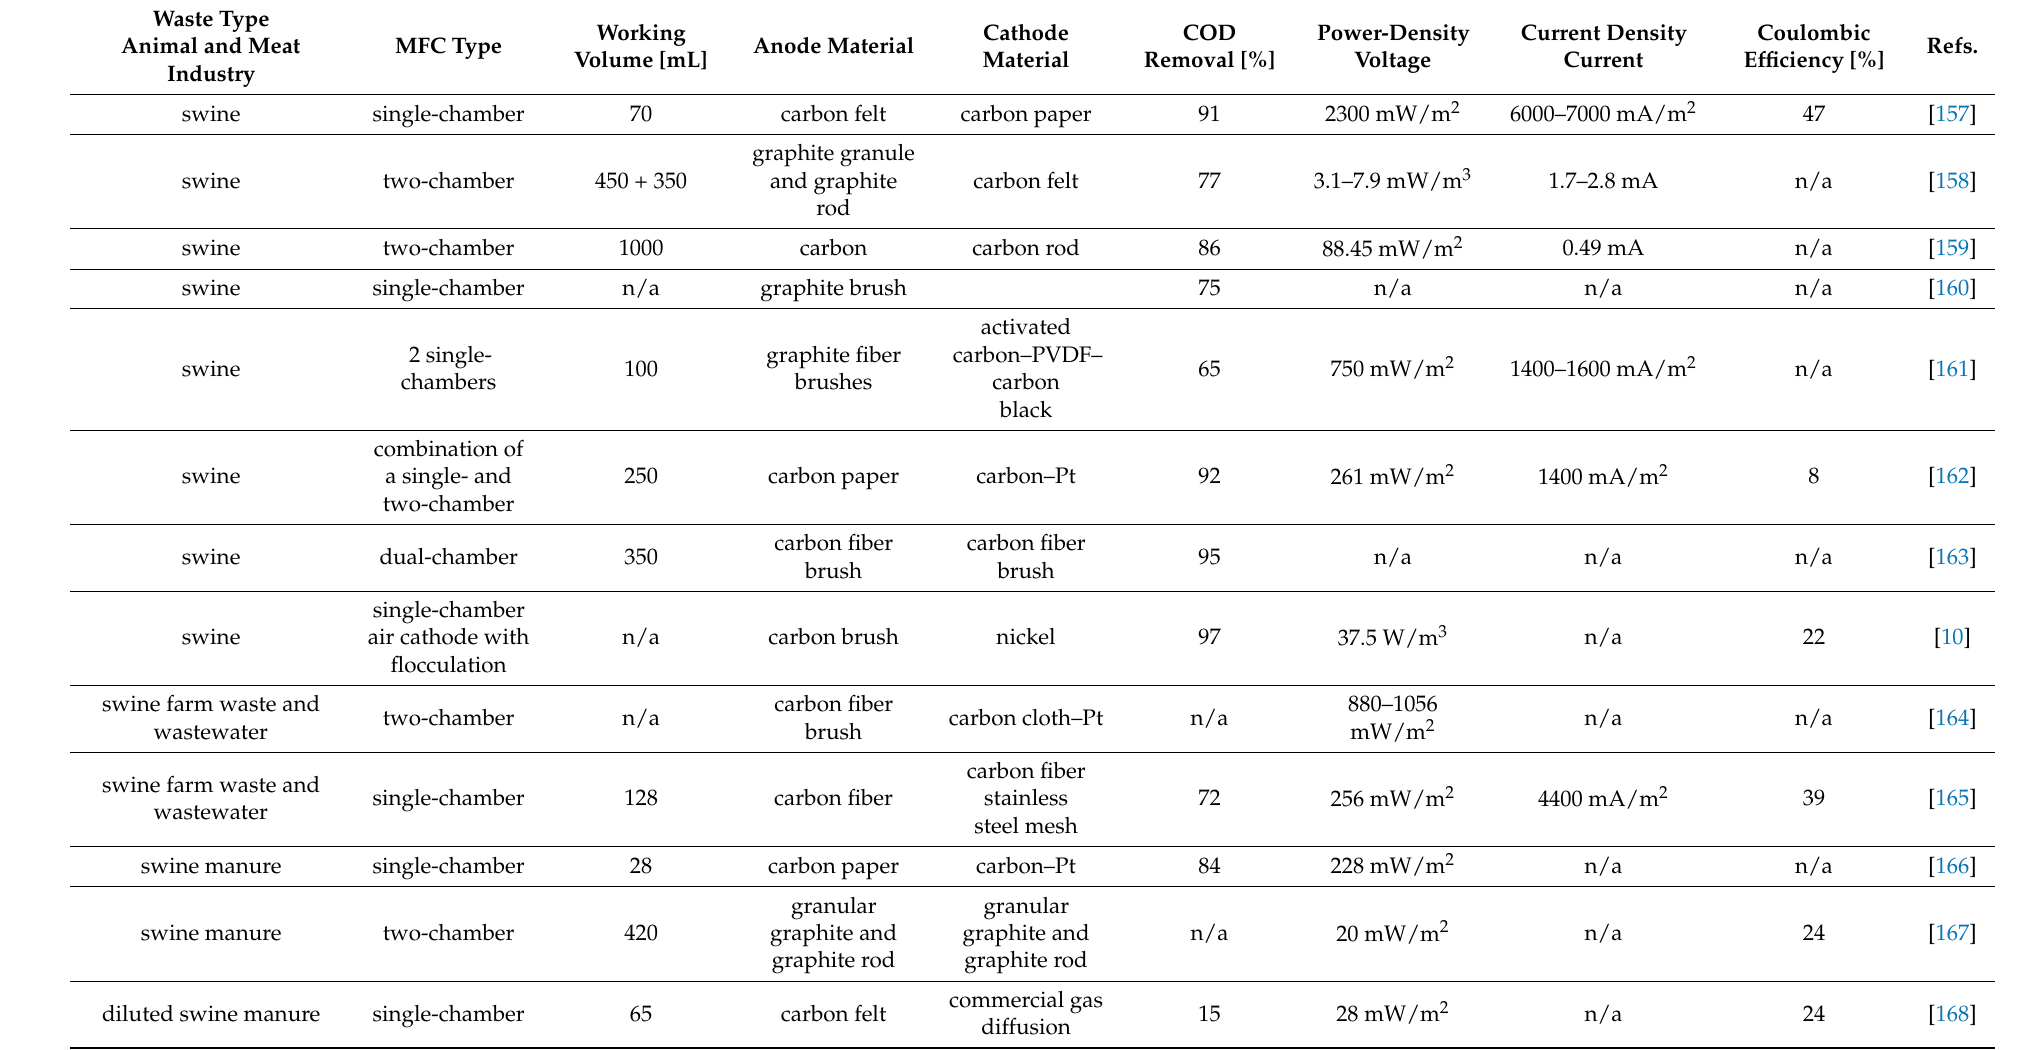
Table A6. Summary of studies reporting use of animal and meat industry waste in